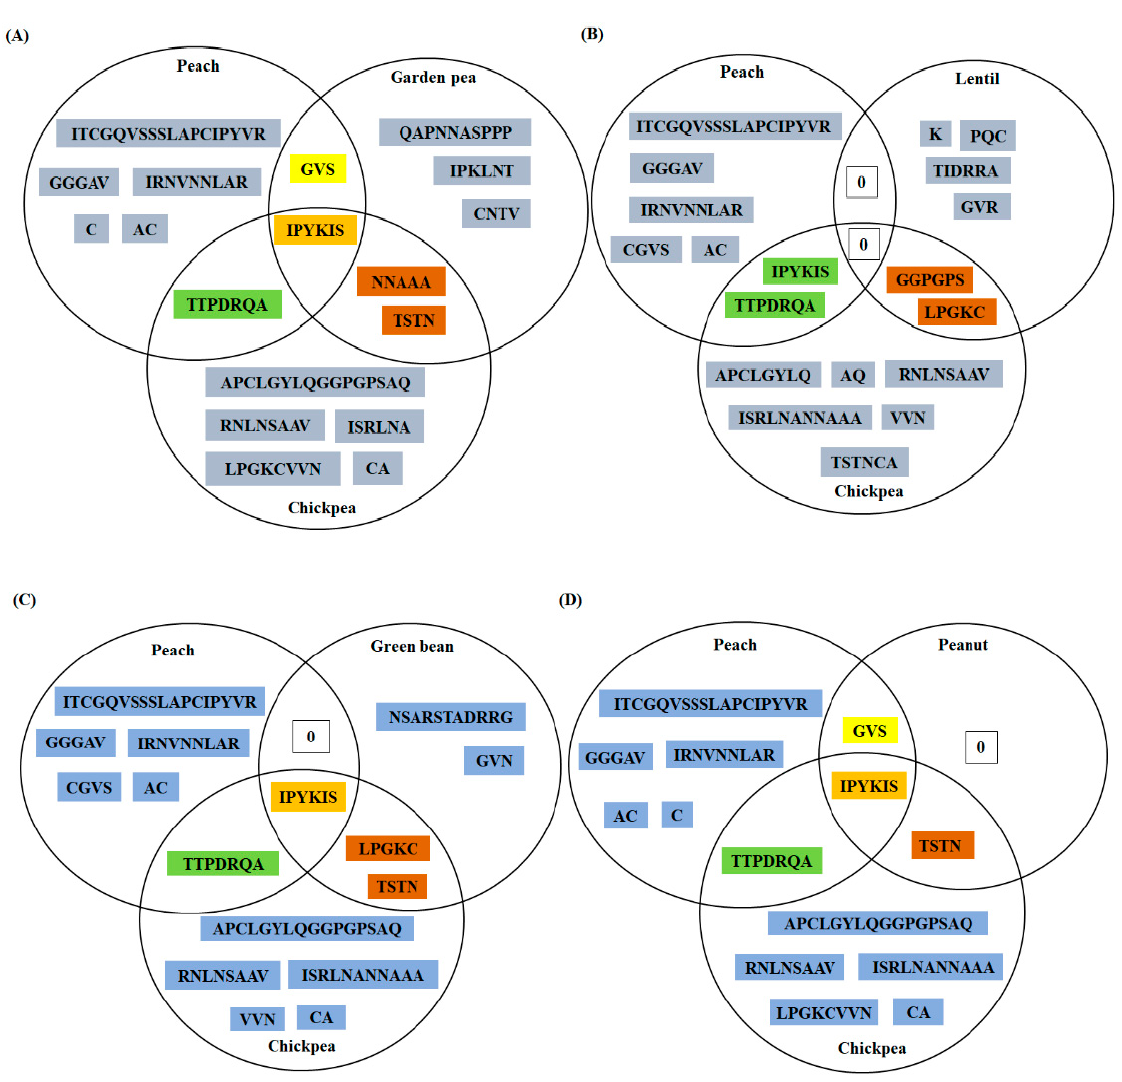
Figure 3. Triads were used for comparing the predicted epitopes of chickpea LTP with the predicted epitopes of peach and other four allergenic legumes. Total four Venn diagrams were generated for chickpea LTP, i.e., chickpea and peach were common to each diagram, only replacement was the allergenic legume LTP, in the order—( A ) garden pea, ( B ) lentil, ( C ) green bean, and ( D ) peanut, respectively. Only predicted epitopic residues were mentioned in the diagram and ‘0’ denoted absence of any identical regions.